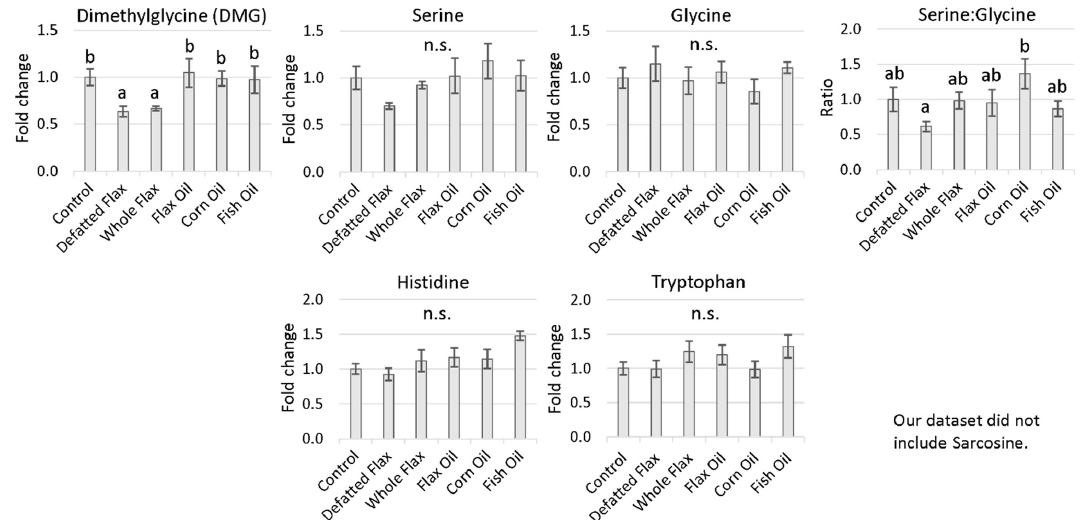
Figure 6. Folate cycle carbon donors that contribute to 5,10-CH 2 THF synthesis: Hen plasma samples were measured via LC-MS/MS. VIP scores of metabolites were analyzed via one-way ANOVA (Duncan’s post-test, p < 0.05). Groups lacking a similar letter (i.e., a,b) are significantly different. “n.s.” is used to illustrate a non-significant ANOVA. The sample size from each diet group is listed in the Materials and Methods section (Section 5.3). Error bars are +/ − SEM.